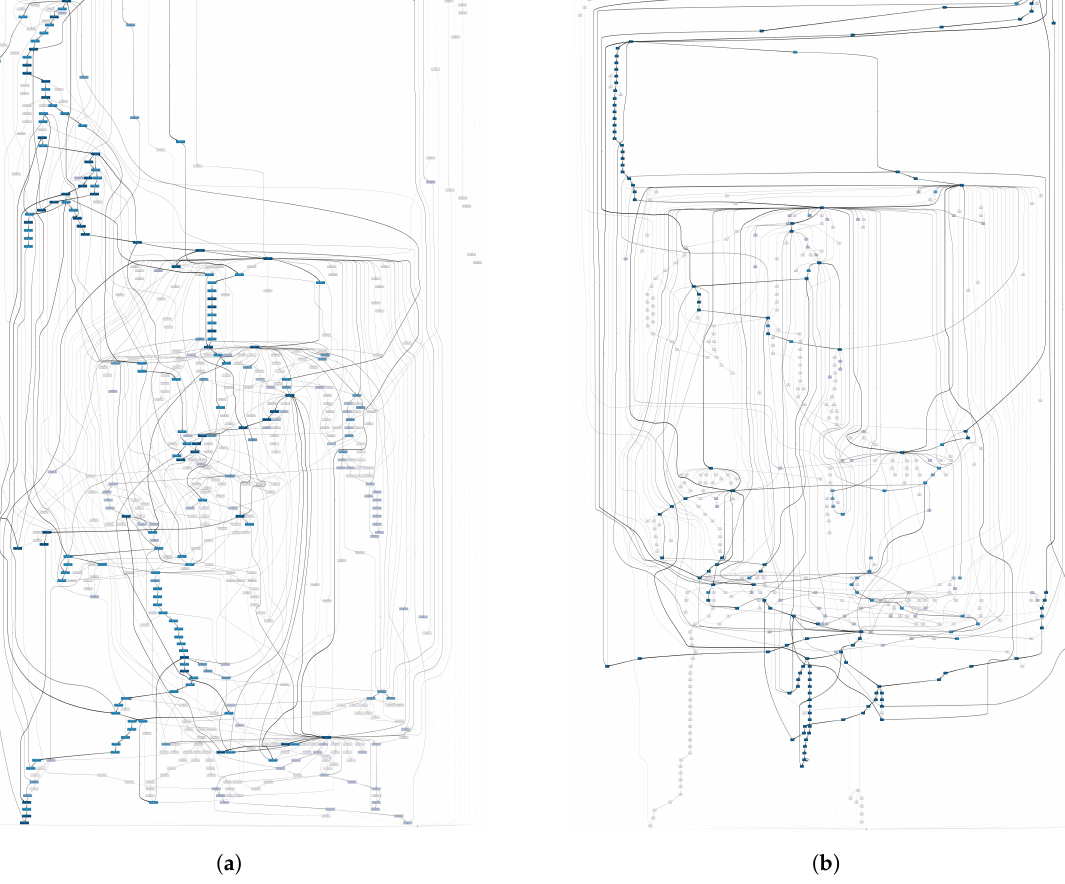
Figure 13. Separate Heuristic miner models of high level categories in the process log. ( a ) Heuristic miner model of the cases related to Class-A (Broadband customers); ( b ) Heuristic miner model of the cases related to Class-B (PSTN